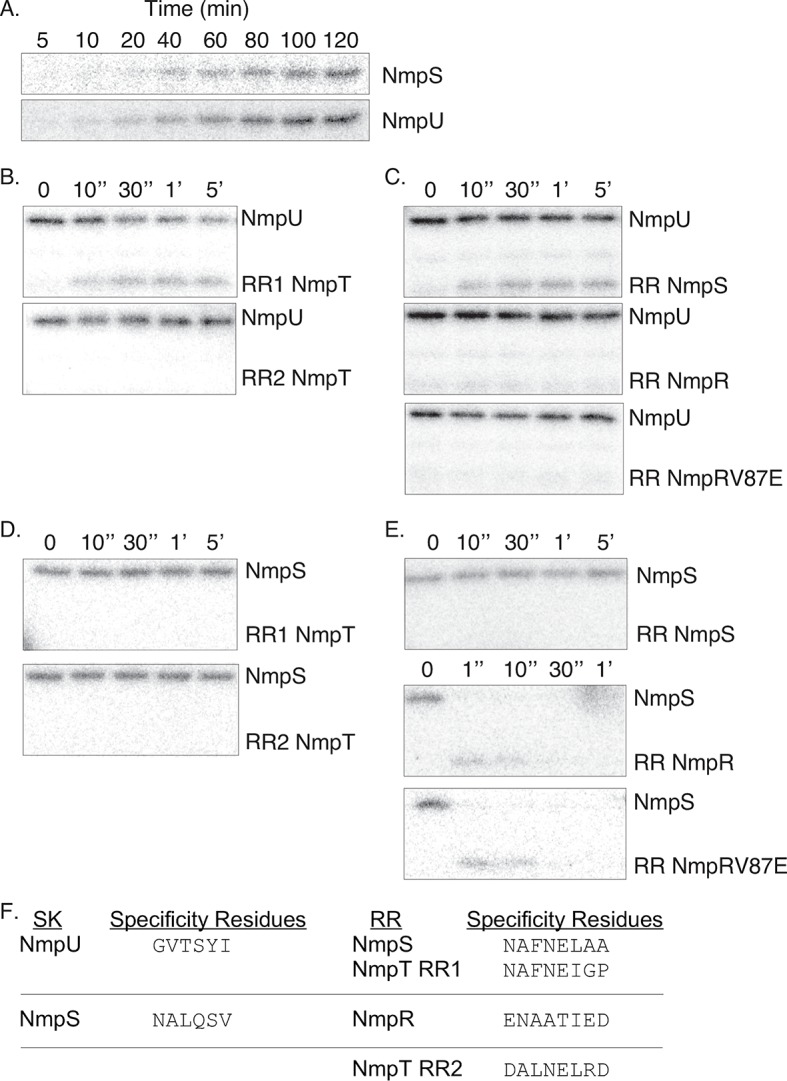
In vitro phosphotransfer in the NmpRSTU multi-component pathway.(A) The kinases NmpS and NmpU autophosphorylate in the presence of ATP-γP32 as seen by the accumulation of the radioactive phosphoryl group. NmpU specifically phosphorylates the first receiver domain of NmpT (RR1) and the receiver domain of NmpS (B and C). In contrast, NmpS only phosphorylates NmpR (D and E). Note the rapid kinetics of the phosphorylation of NmpR by NmpS (E). Also, the V87E amino acid change of NmpR does not affect the specificity of the phosphotransfer (C and E). The specificity residues [10, 11, 96] of the SK domains of NmpS and NmpU and the corresponding specificity residues of the receiver domains of NmpR, NmpS, and NmpT further supports the observed phosphotransfer patterns (F).